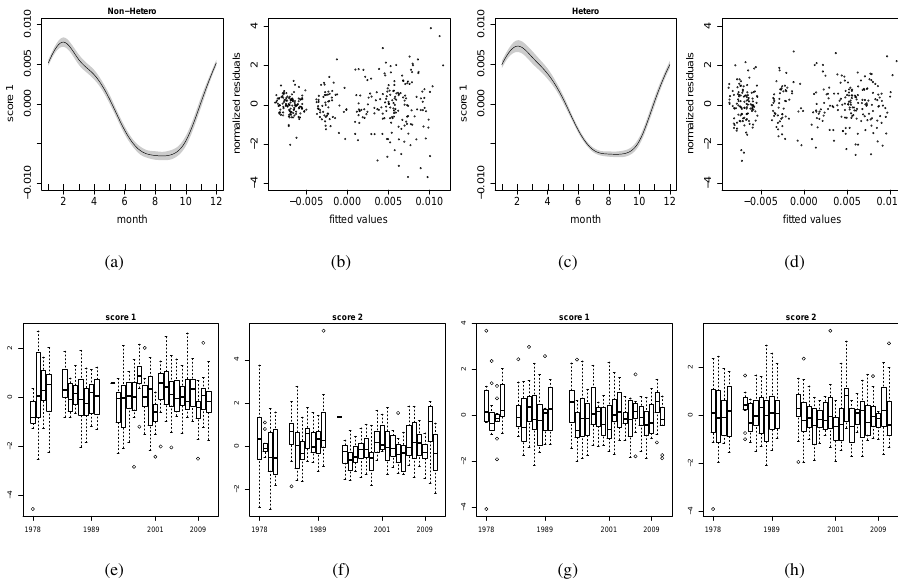
Fig. 10. (a) The fitted month curve (PC score 1 for Boulder) and its 95% Bayesian confidence intervals when constant distribution is assumed for the error. (b) The fitted PC score 1 versus normalized residuals from the AMMs with the constant distribution assumption for Boulder. (c) The fitted month curve (PC score 1 for Boulder) and its 95% Bayesian confidence intervals with the heteroscedastic error assumption. (d) The fitted PC score 1 versus normalized residuals from the AMMs with the heteroscedastic error assumption for Boulder. (e) Box plots of normalized residuals grouped by year: for Boulder, (e) and (f) , and for Arosa, (g) and (h)